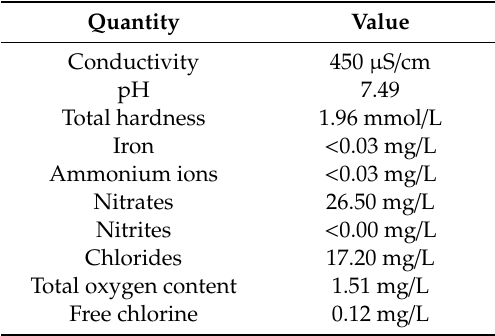
Figure 2. Scheme of water absorption (left) and water holding (right) experiment. 1—Kopecky’s roll; 2—soil; 3—direction of tap water flow; 4—stainless steel mesh; 5—filter paper; 6—tap water reservoir; 7—4 layers of dry filter paper. Table 1. Tap water composition